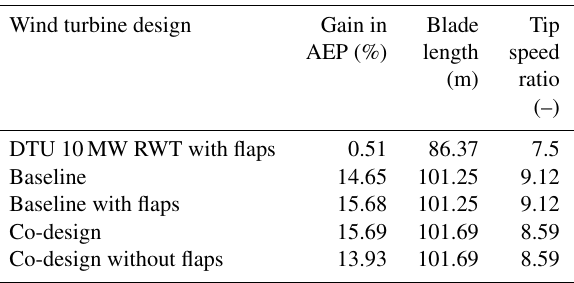
Table 5. Summary of optimization results.